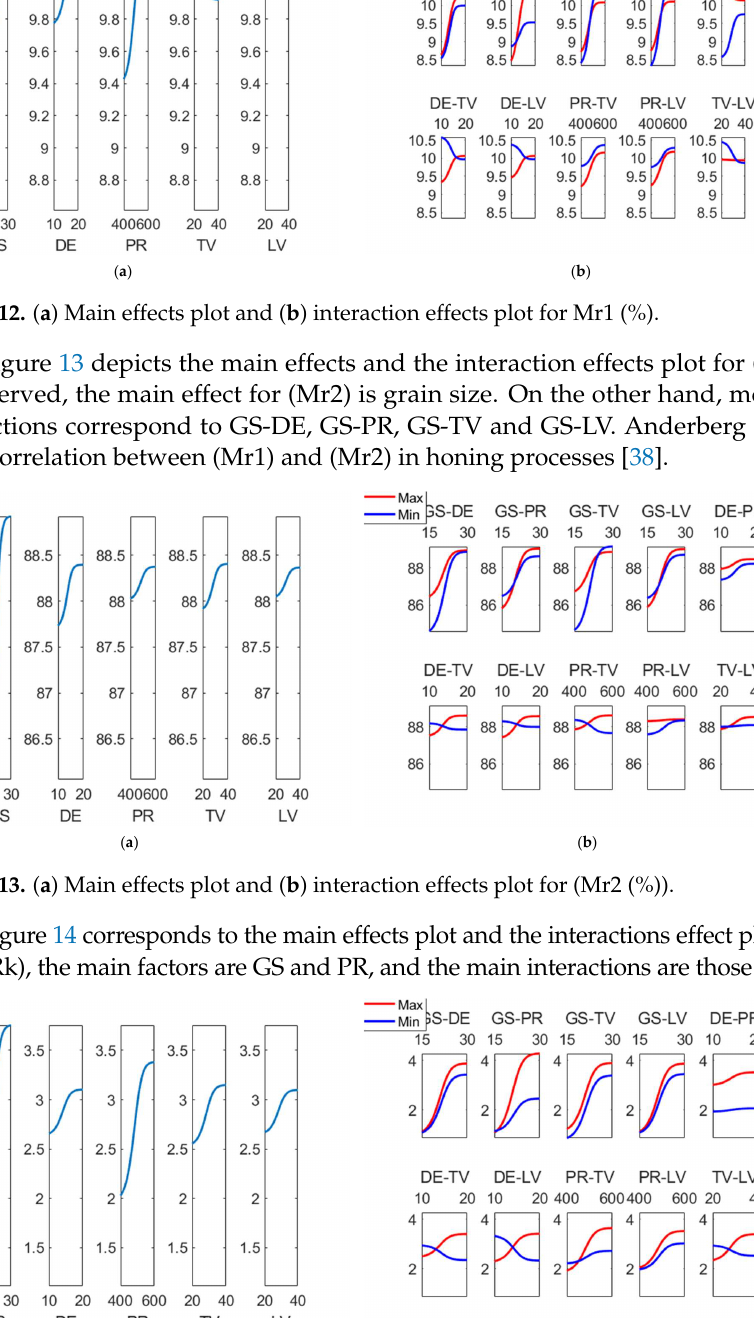
Figure 11. Response surface for (Mr1 (%)) versus each pair of input variables while the rest are kept at their central values, using the ANFIS developed for (Mr1): ( a ) GS and DE; ( b ) GS and PR; ( c ) GS and TV; ( d ) GS and LV; ( e ) DE and PR; ( f ) DE and TV; ( g ) DE and LV; ( h ) PR and TV; ( i ) PR and LV; ( j ) TV and LV.